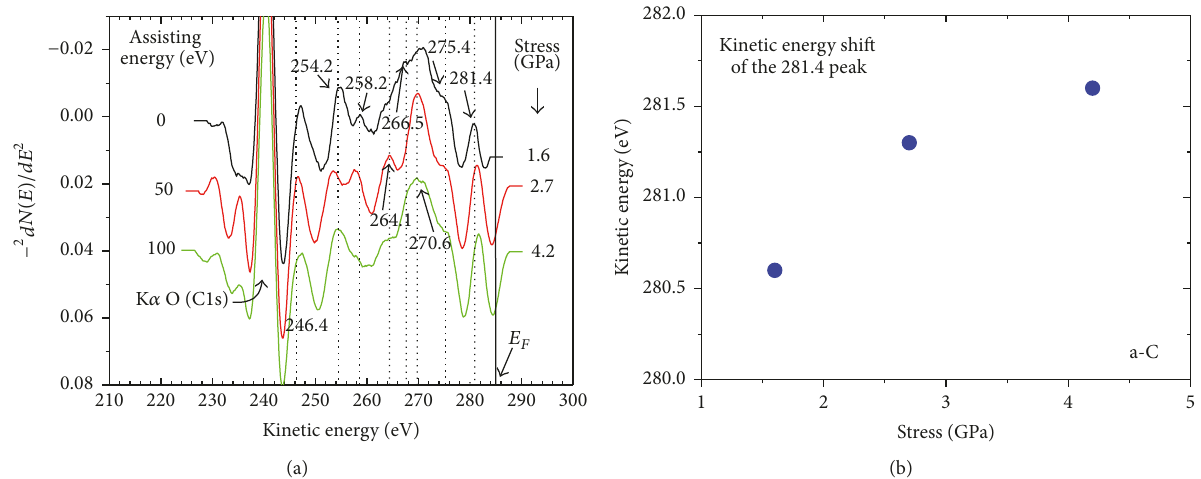
Figure 3: (a) Second derivative of the XAES KVV from a-C thin films with different pressure (stress). The Fermi energy was determined using C 1s in 284.3 eV. The very intense peak at approximately 240.5 eV is due to excitation of C 1s core by K 𝛼 of O adsorbed on the anode of the X-ray tube. (b) Kinetic energy of the 𝑝 𝜋 valence states as a function of the carbon film stress in amorphous carbon. The dotted lines are guides to the